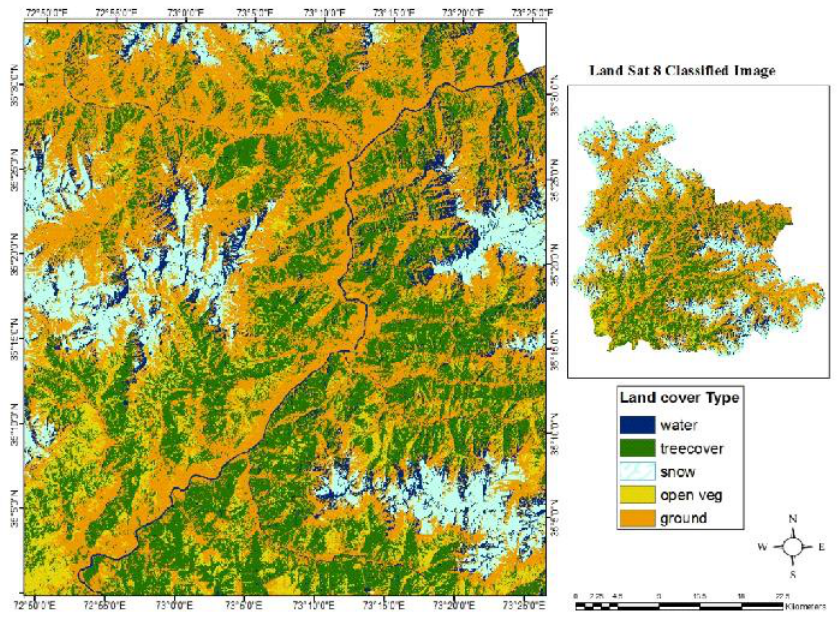
Fig. 4: Supervised classification of LANDSAT 8